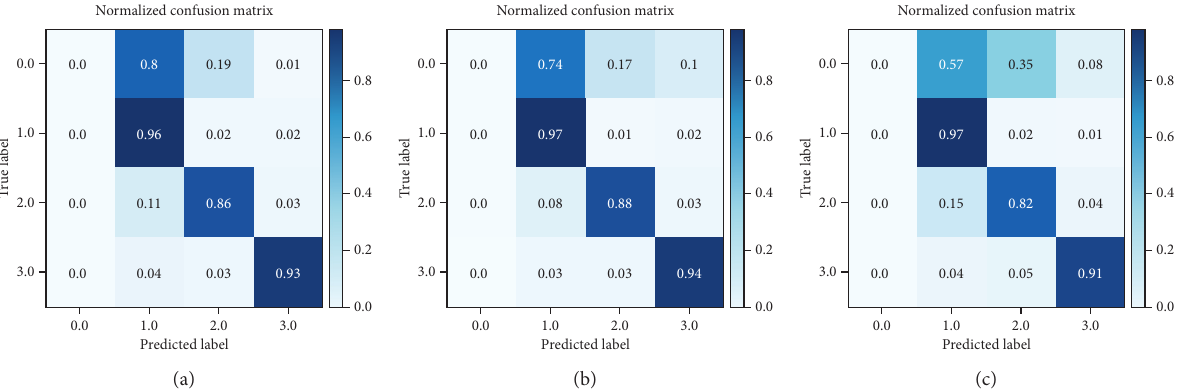
Figure 8: Confusion matrix of three gait patterns derived from AdaBoosting classification under three paces. Settings: 0.78 m/s (a), 1.0 m/s (b), and 1.25m/s (c).